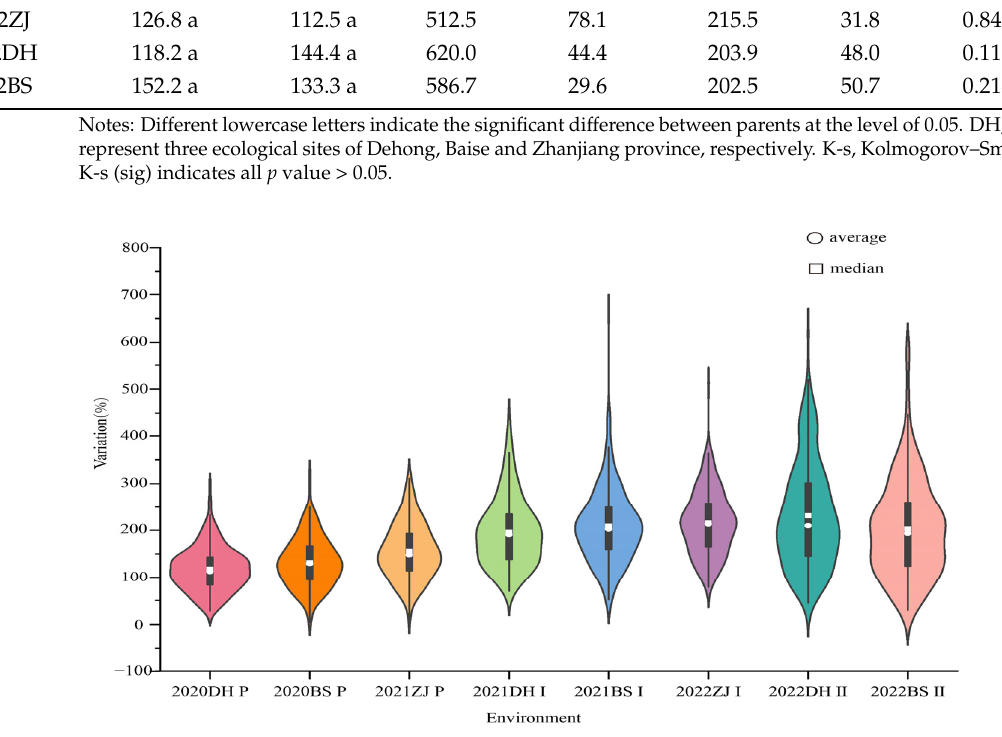
Figure 2. The variation in the tillering rate and the ratoon sprouting rate of 285 F 1 progenies in different environments. DH, BS, ZJ represent three ecological sites of Dehong, Baise and Zhanjiang province, respectively; p , I and II represent the tillering rate in the plant cane, the first ratoon sprouting rate and the second ratoon sprouting rate, respectively.